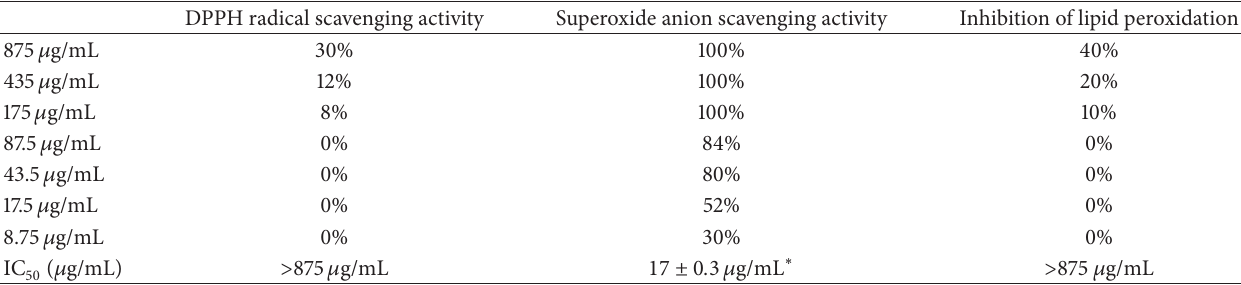
Table 3: DPPH radical, superoxide anion scavenging activity, and inhibition of lipid peroxidation by different concentrations of EPS50MAE. Each value represents the mean ± SD of 4 experiments in